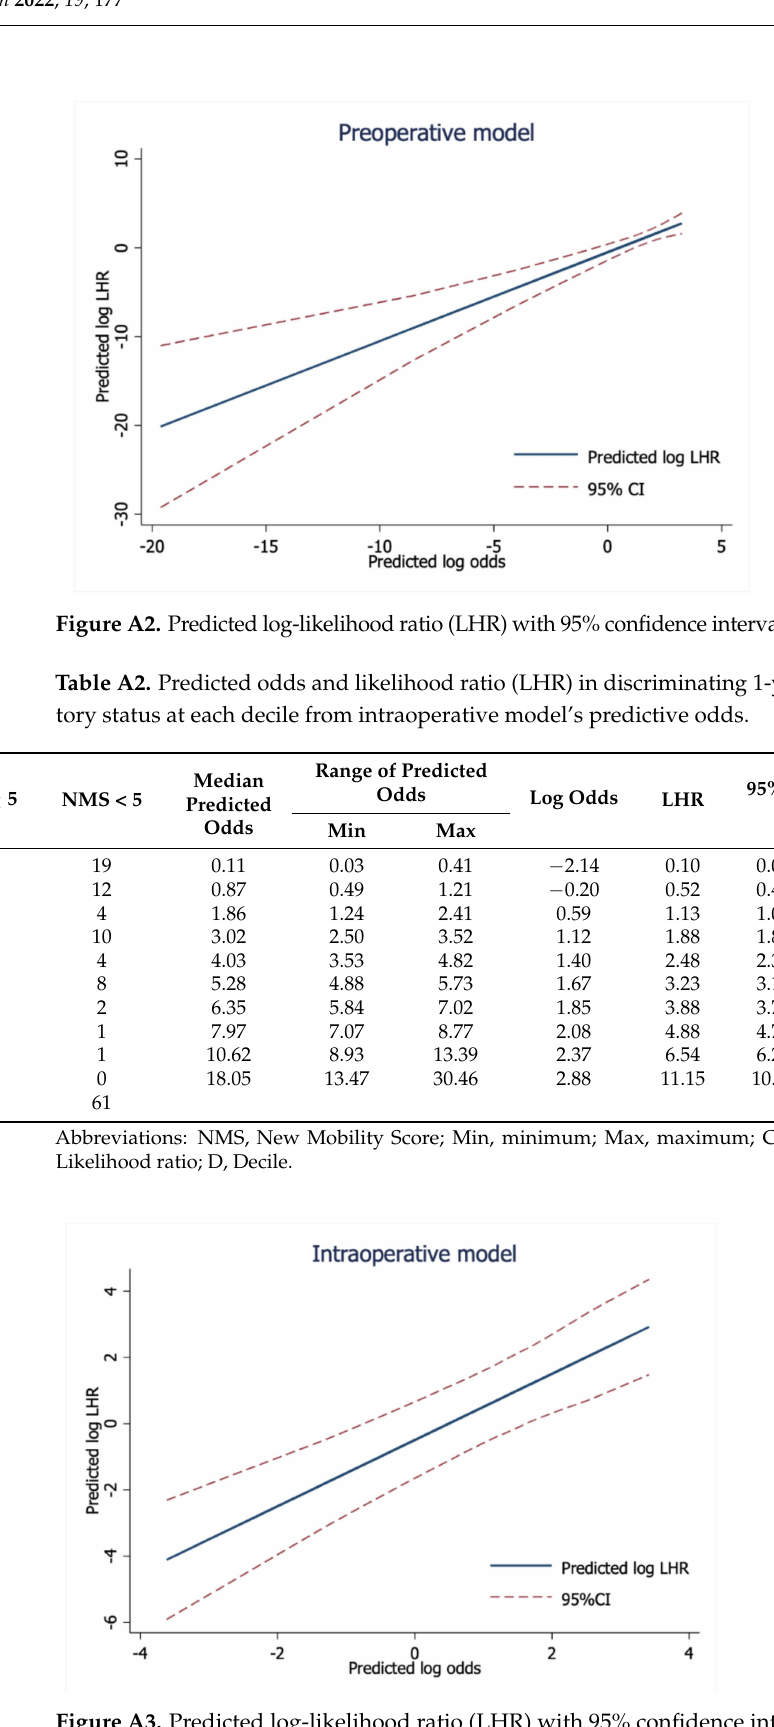
Figure A3. Predicted log-likelihood ratio (LHR) with 95% confidence interval of the intraoperative